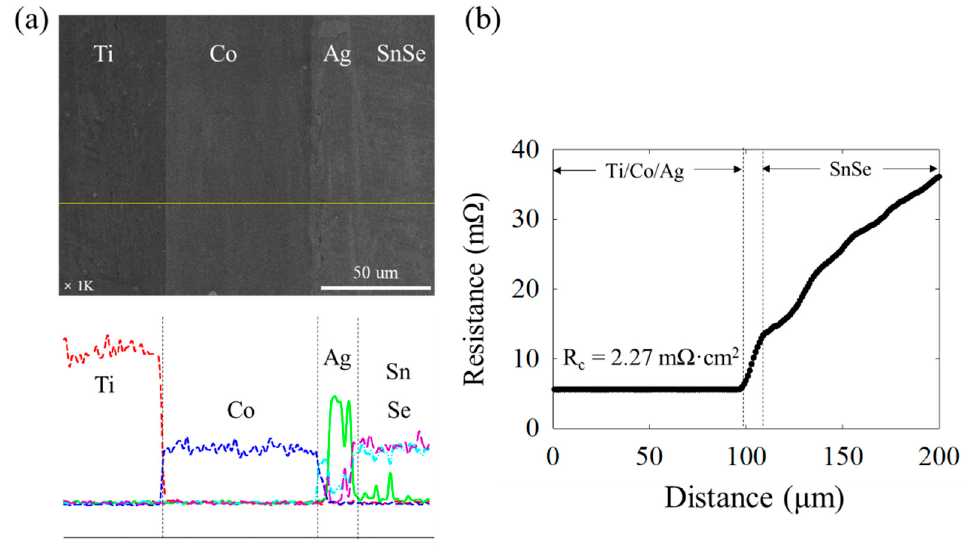
Figure 7. ( a ) SEM image and EDS line scanning of the Ag/Co/Ti multi-layer metallization; and ( b ) the graph of SCR after heat treatment at 723 K for 20 h.